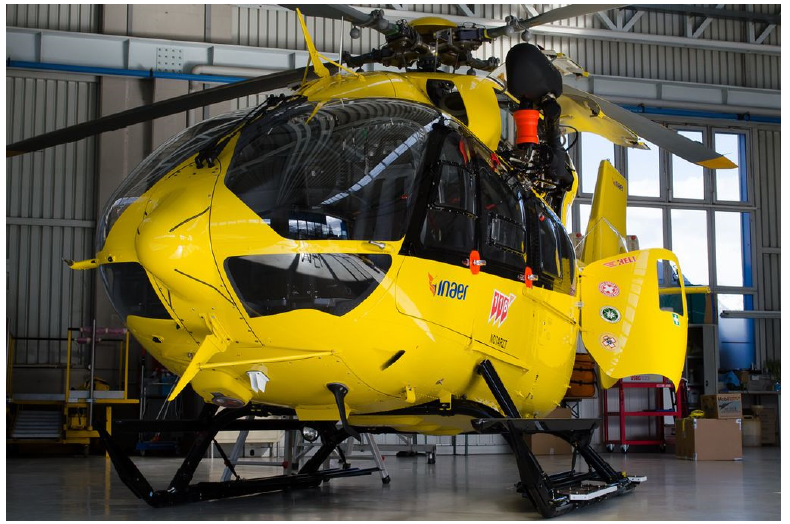
Figure 1. Airbus helicopter [47].